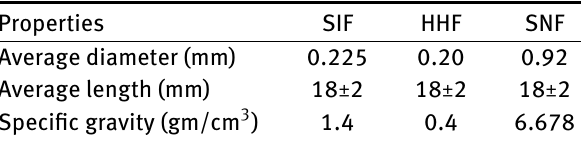
Table 3: Fibers properties.